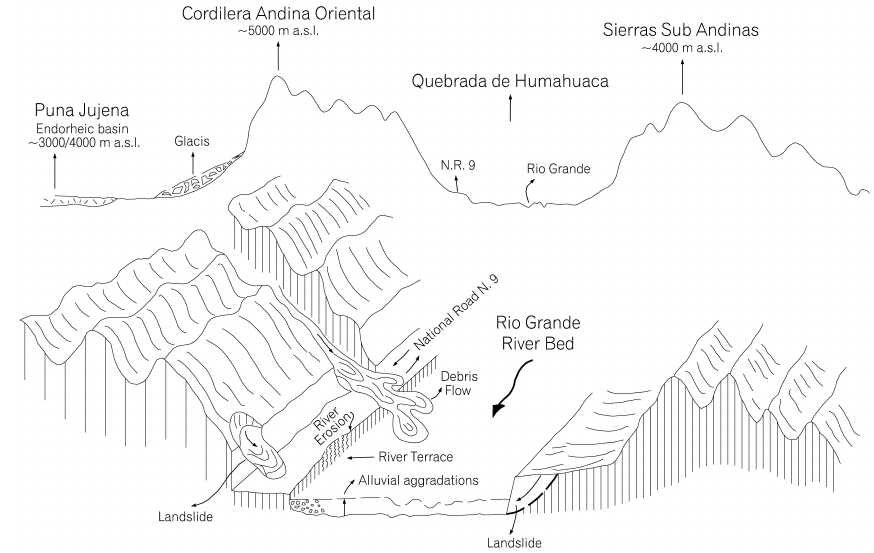
Fig. 2. Sketch of the main geomorphological processes and landforms active in the Quebrada de Humahuaca at